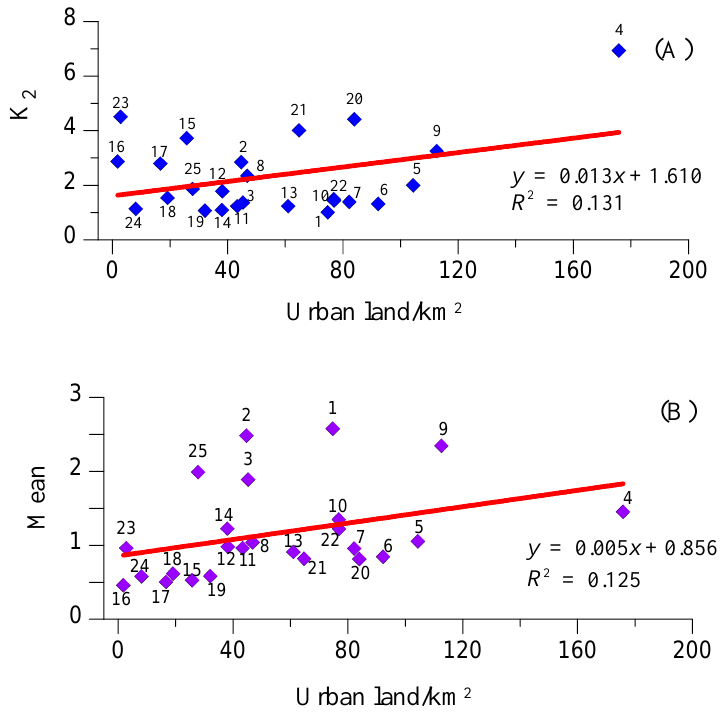
Figure 14. Scatter plot of the interprovincial differences in urban land use with K 2 (A) and mean land scale (B).